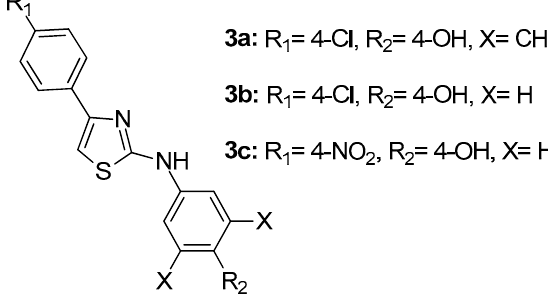
Figure 4. Chemical structures of N-aryl-4-aryl-1,3-thiazole-2-amine derivatives 3a – c .